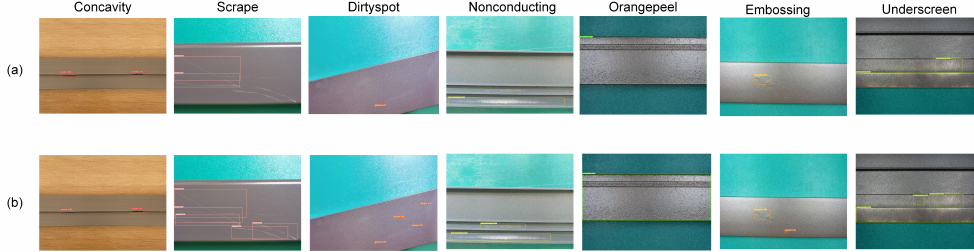
Figure 12. Comparison of YOLOv5 and MS-YOLOv5 results for seven defects. ( a ) Result of YOLOv5; ( b ) Result of MS-YOLOv5.